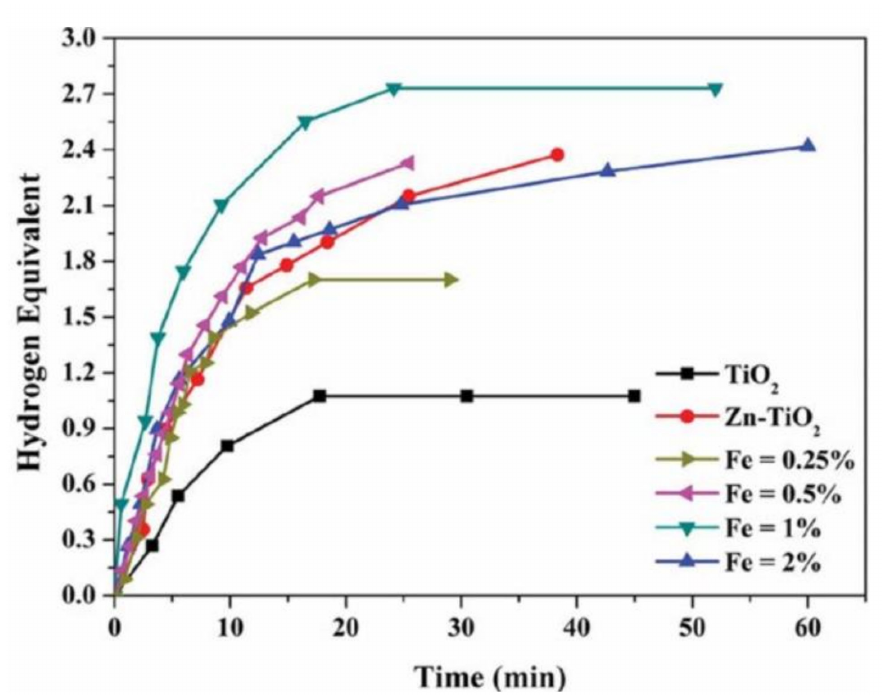
Figure 23. Photocatalytic performance of TiO 2 NFs with and without Zn and Fe for AB hydrolysis reaction. Reprinted from reference [7] with permission from Taylor & Francis.